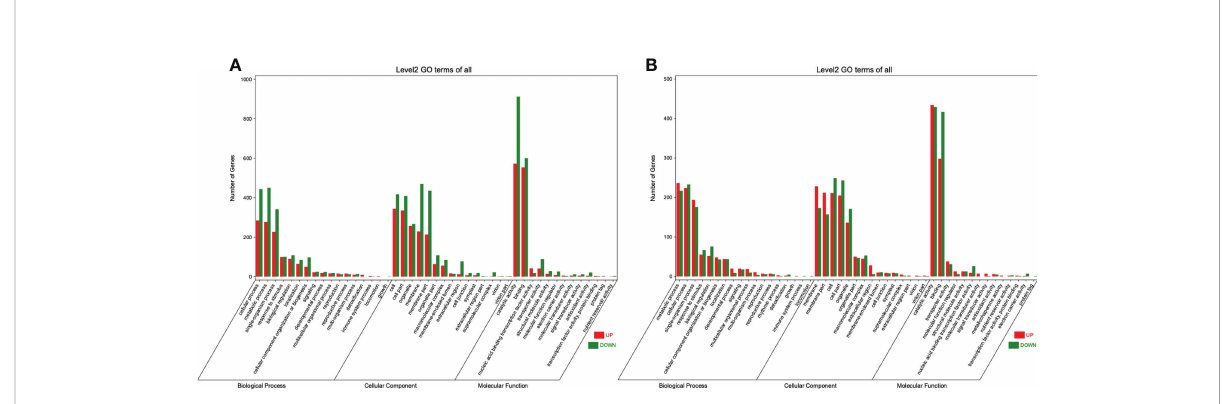
FIGURE 4 GO enrichment classi fi cation of DEGs in P. ostii roots. (A) , Waterlogging treatment (CK VS WT); (B) , Waterlogging recovery treatment (WT VS